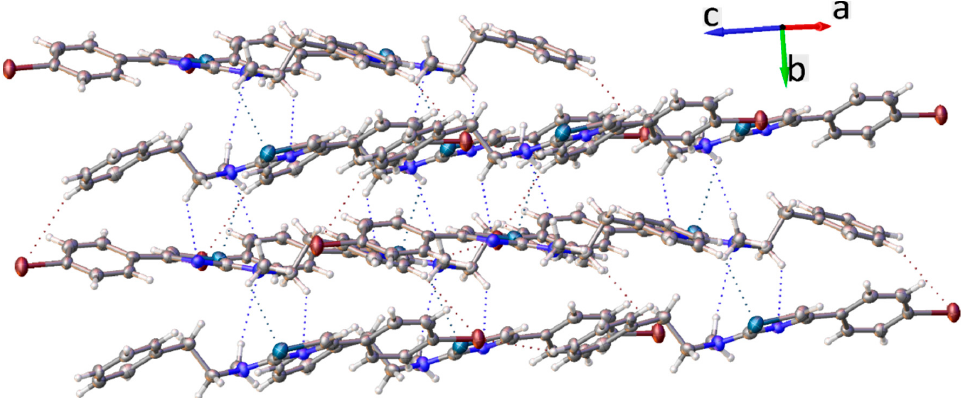
Figure 3. The packing framework shows the intermolecular C-H ∙∙∙ Se, C-H ∙∙∙ N and C-H ∙∙∙ Br close contacts in 12 . contacts in 12